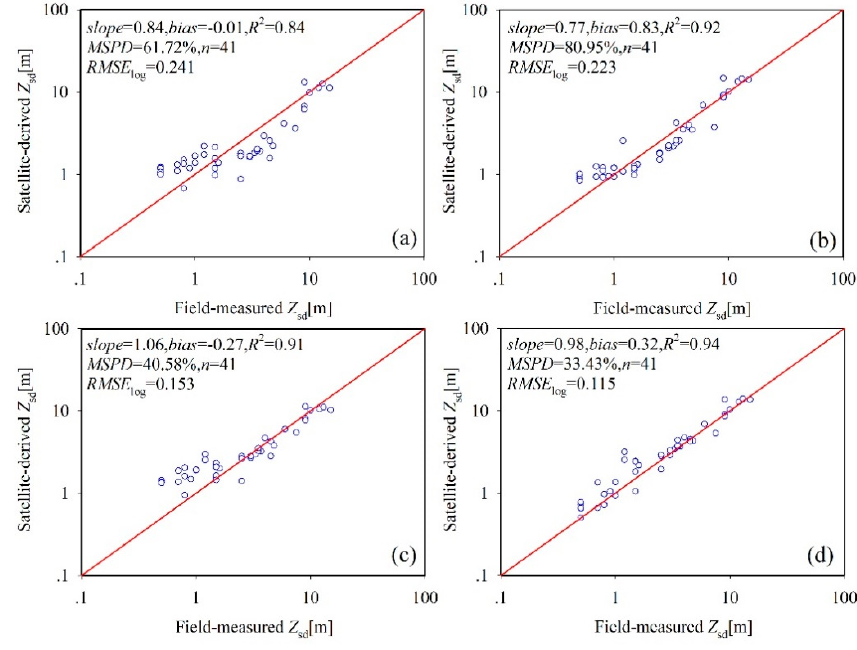
Figure 4. Accuracy of satellite-derived Z sd products using ( a ) BGSD, ( b ) IOPSD, ( c ) MKSD, and ( d ) CSSD models in the CECZ seas in Table 1.